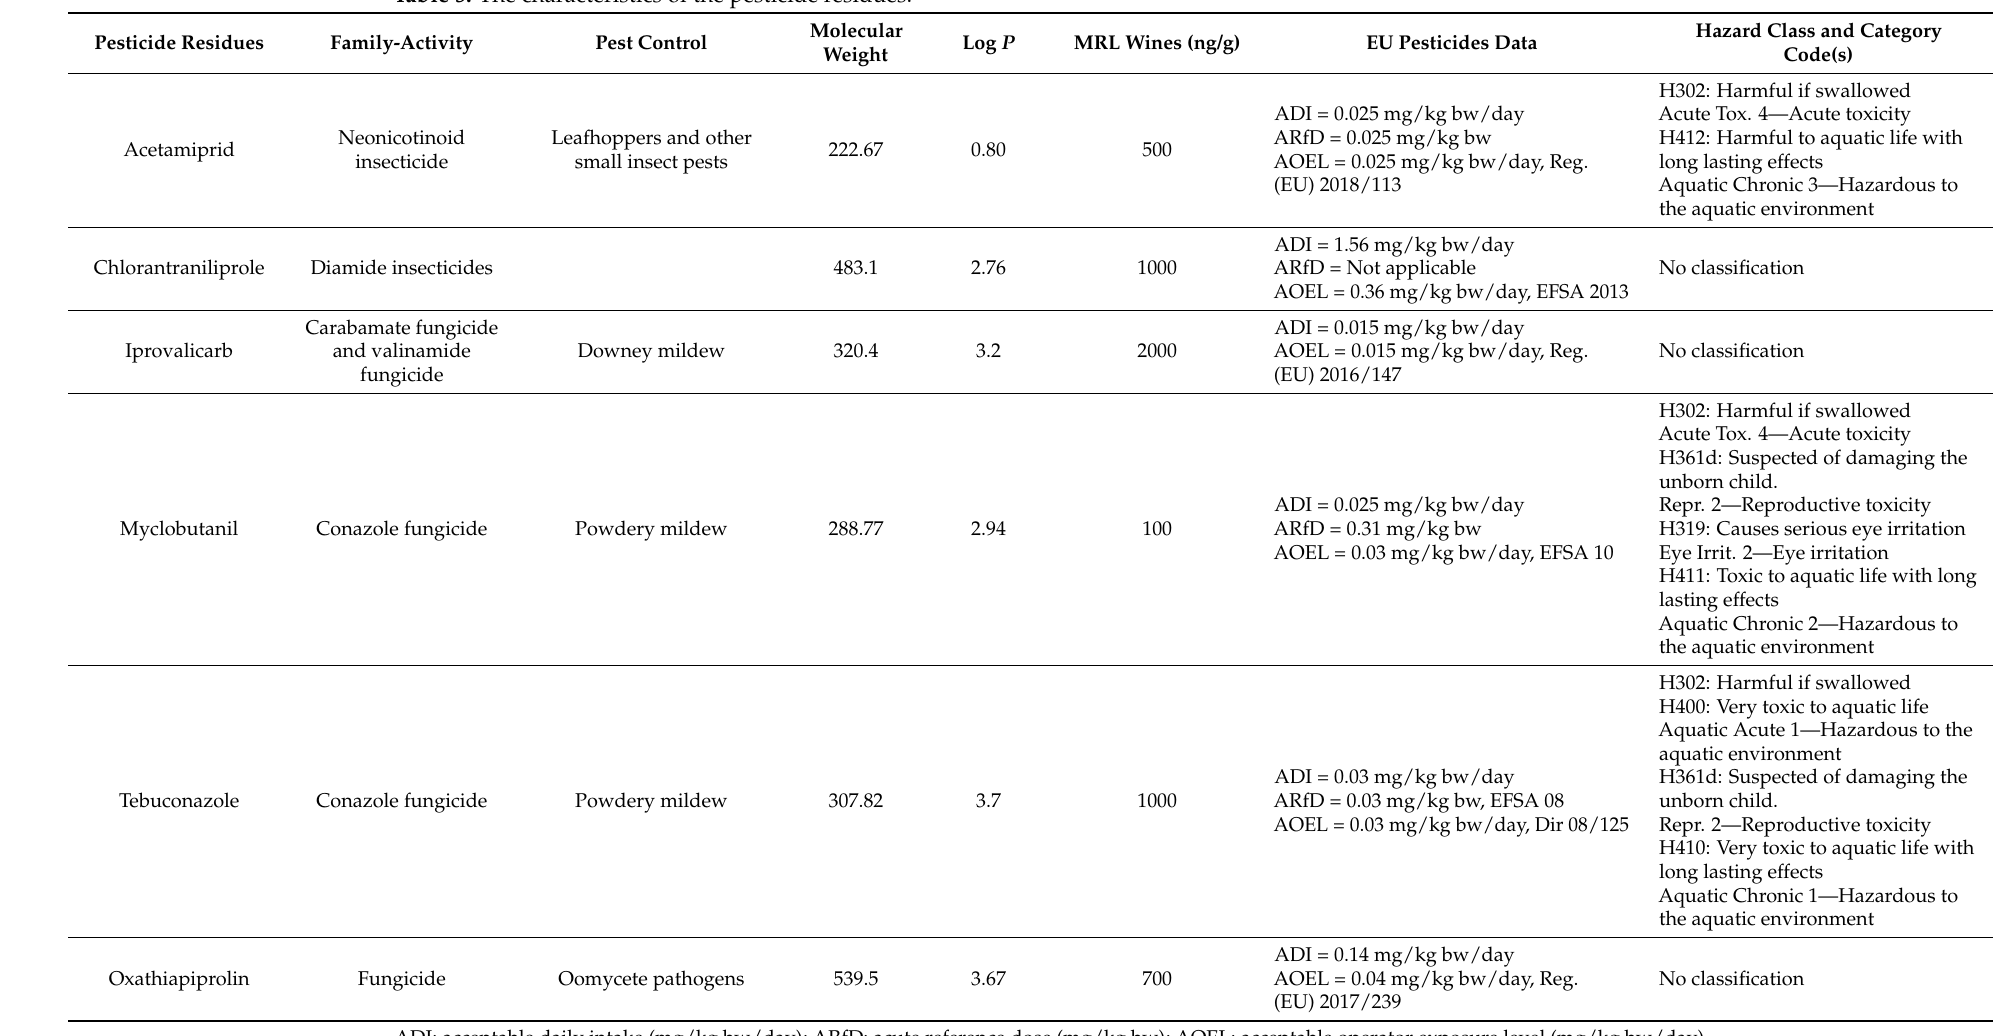
Table 5. The characteristics of the pesticide